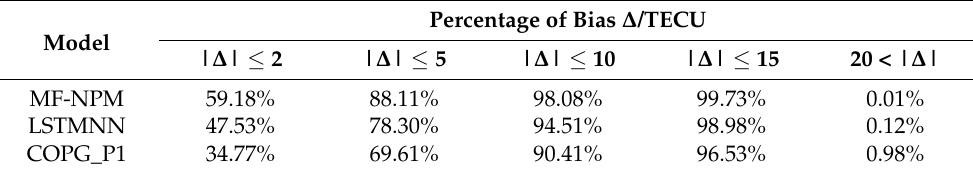
Figure 8. Histograms for MF-NPM, LSTMNN, and COPG_P1 with reference to IGS GIM during geomagnetic storms period. Table 5. Percentage of bias distributions of MF-NPM, LSTMNN, and